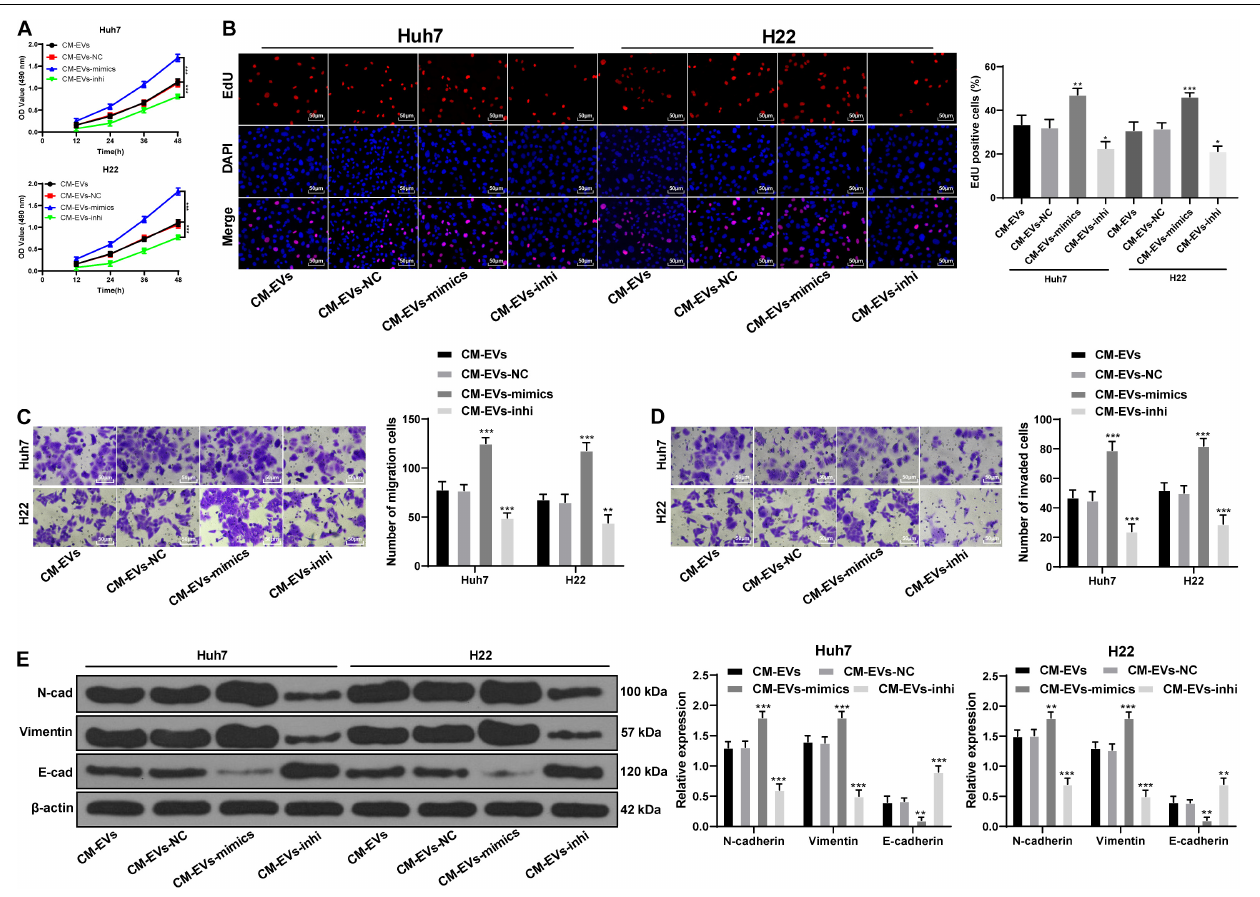
FIGURE 5 | miR-181d-5p reduction in hepatoma cell-derived EVs reduced the effects of BMSCs on EMT and invasion of hepatoma cells. (A) MTT assay was used to detect the proliferation ability of Huh7 and H22 cells at different time points. (B) EdU assay was used to detect the proliferation ability of Huh7 and H22 cells. (C,D) Transwell assays were used to detect the invasion and migration abilities of Huh7 and H22 cells. (E) Western blot analysis was used to detect the expression of EMT-related proteins in Huh7 and H22 cells; compared with the CM-EVs group. * p < 0.05, ** p < 0.01, *** p < 0.001. Data were analyzed by one-way ANOVA, followed by Tukey’s multiple comparison test. Replicates =